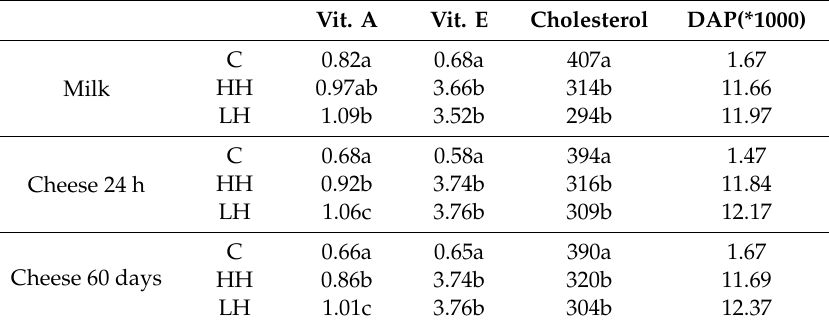
Table 2. Levels of vitamin A, vitamin E, cholesterol (mg / 100 g fat) and degree of antioxidant protection (DAP) in milk and cheese from goats reared with di ff erent feeding systems [46].